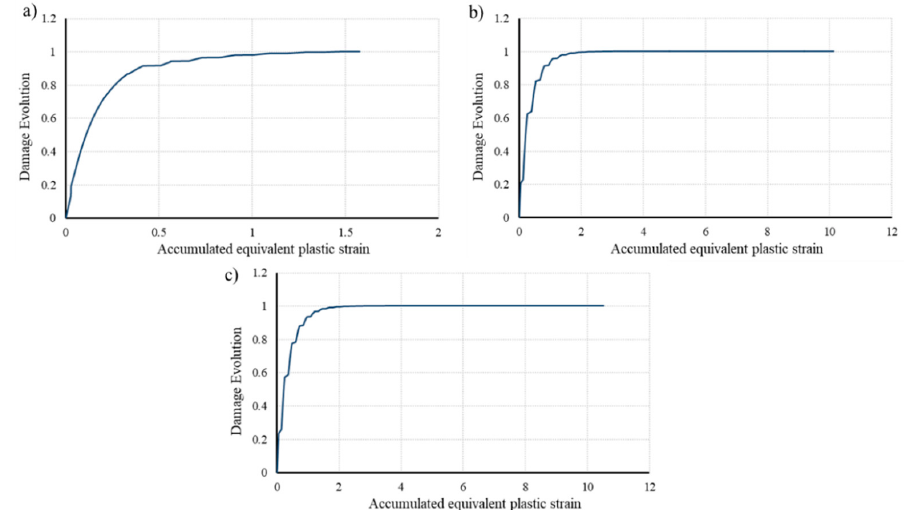
Figure 11. Damage accumulation for “R2” specimens under ELCF. ( a ) Damage accumulation for ten (N f = 10), ( b ) 41 cycles (N f = 41), and ( c ) 51 high-strain reversed cycles (N f = 51).